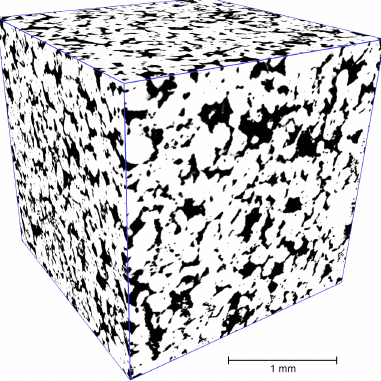
Figure 17. Digital twin of Buff Berea